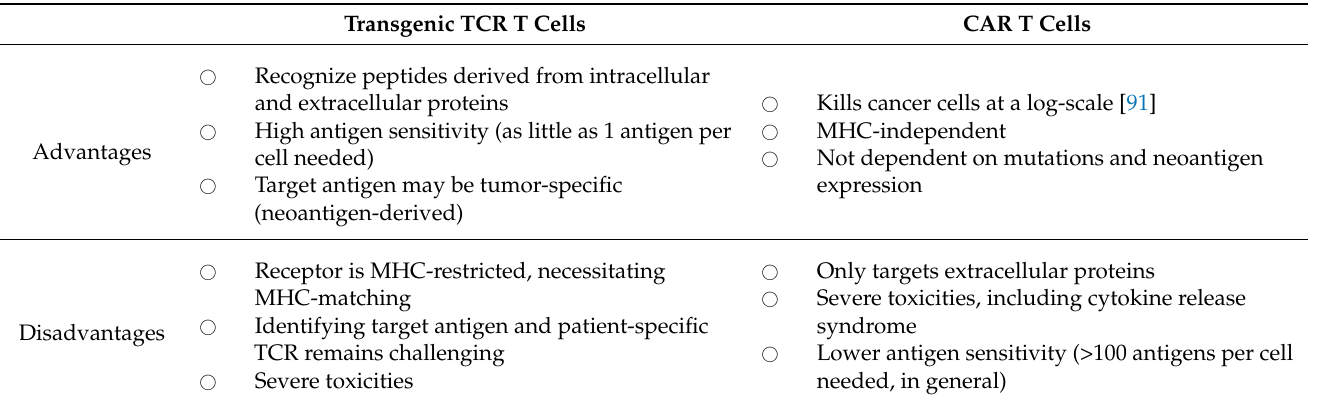
Table 5. Advantages and Disadvantages of transgenic TCR vs. CAR T cell-based